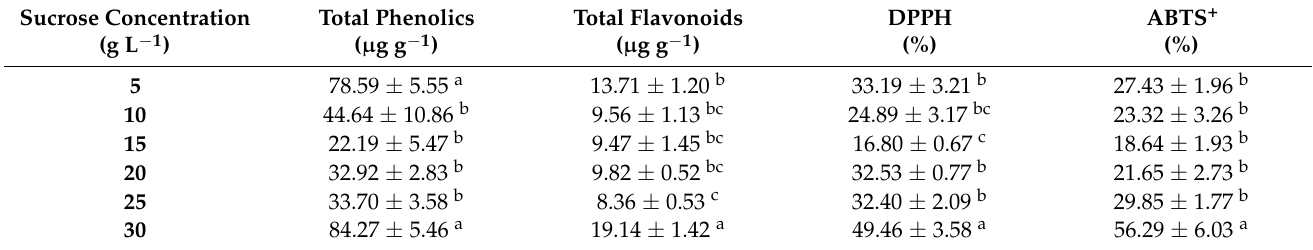
Table 5. Total phenolic, flavonoid contents, and antioxidant capacity in cell suspension cultures of L. schweinfurthii showing the effect of different sucrose